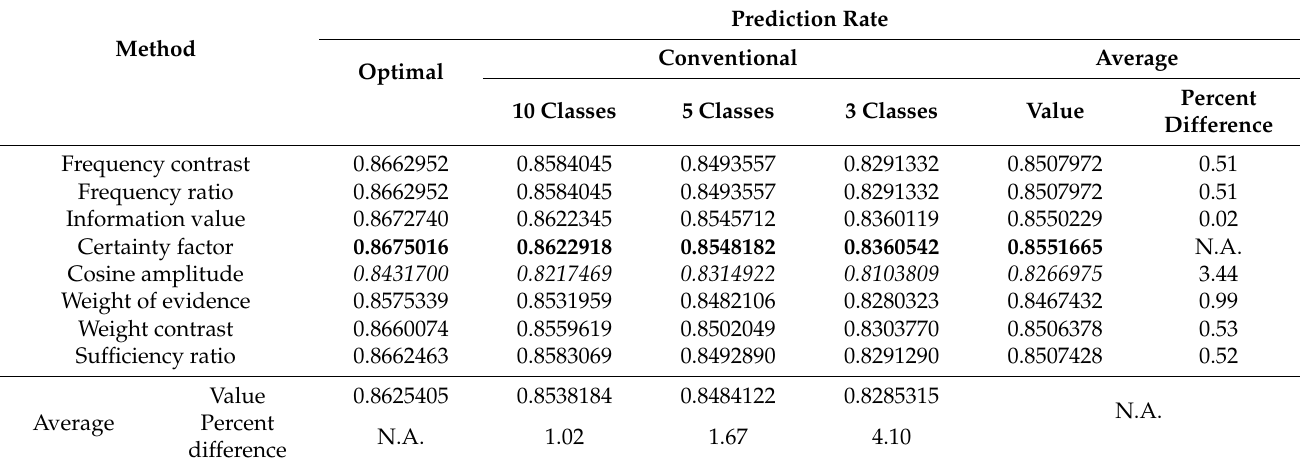
Table 4. Prediction rates of the 32 landslide susceptibility maps produced in the case